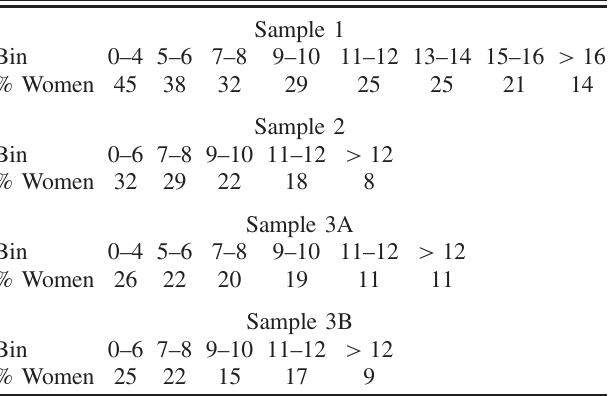
TABLE V. The percentage of women in each pretest score bin for each sample. For sample 1, N ¼ 781 students had pretest score > 16 . For sample 2, N ¼ 250 students had pretest score > 12 . For sample 3A, N ¼ 482 students had pretest score > 12 .